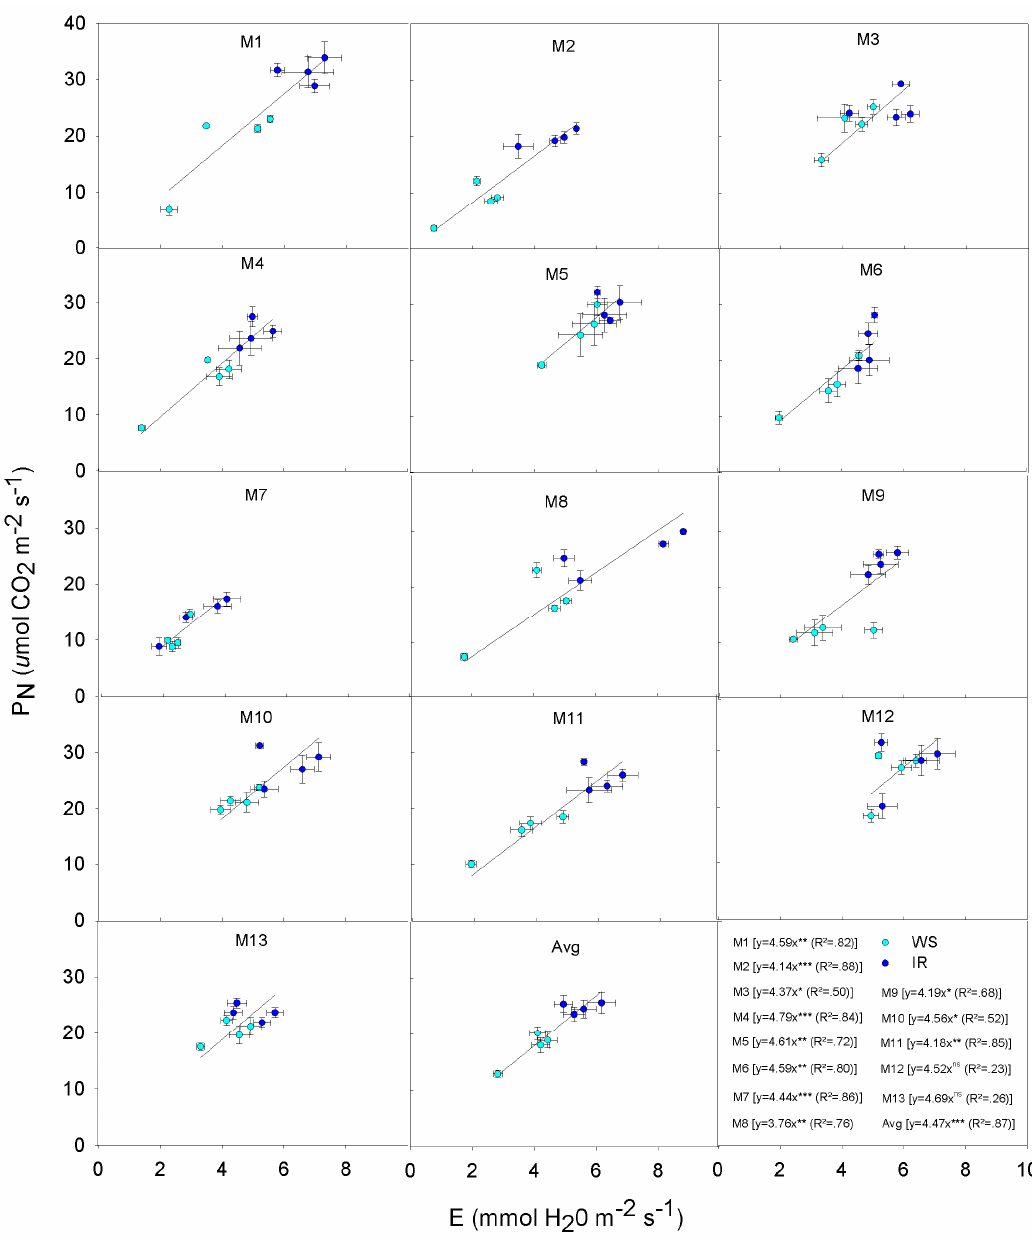
Figure 6. Relationships between transpiration rate (E) and net photosynthesis (P N ) of Miscanthus genotypes under rainfed (WS) and irrigated (IR) conditions in 2014 (the second year following planting). Significant slopes per p ≤ 0.05 (*), p ≤ 0.01 (**), p ≤ 0.001 (***), and not significant (ns).